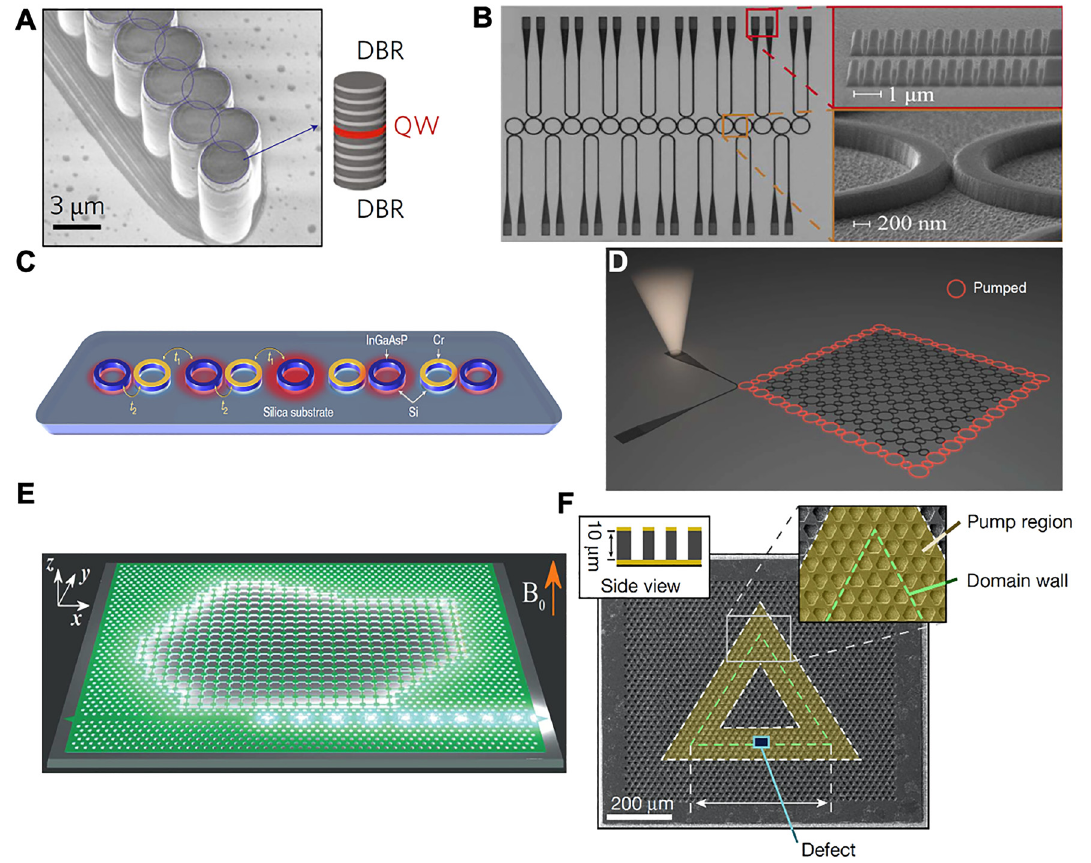
Figure 5: Topological lasers. (A)Lasinginthetopologicaldefectstateofaone-dimensionalSu – Schrieffer –